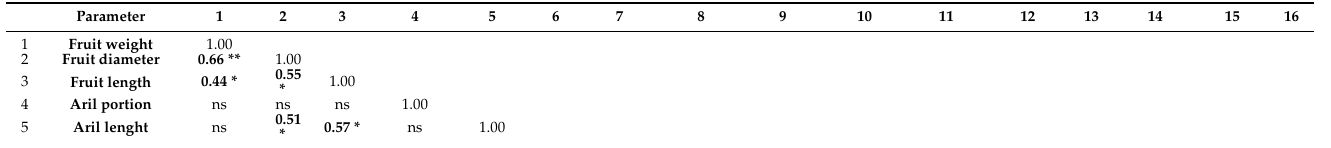
Coefficient of correlation (r) between physical and chemical properties of five pomegranate